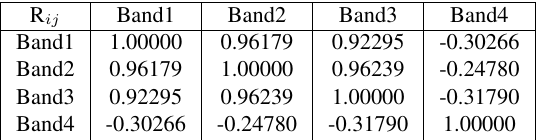
Table 2. Correlation coefficient matrix of GF-1 satellite images bands in the study area